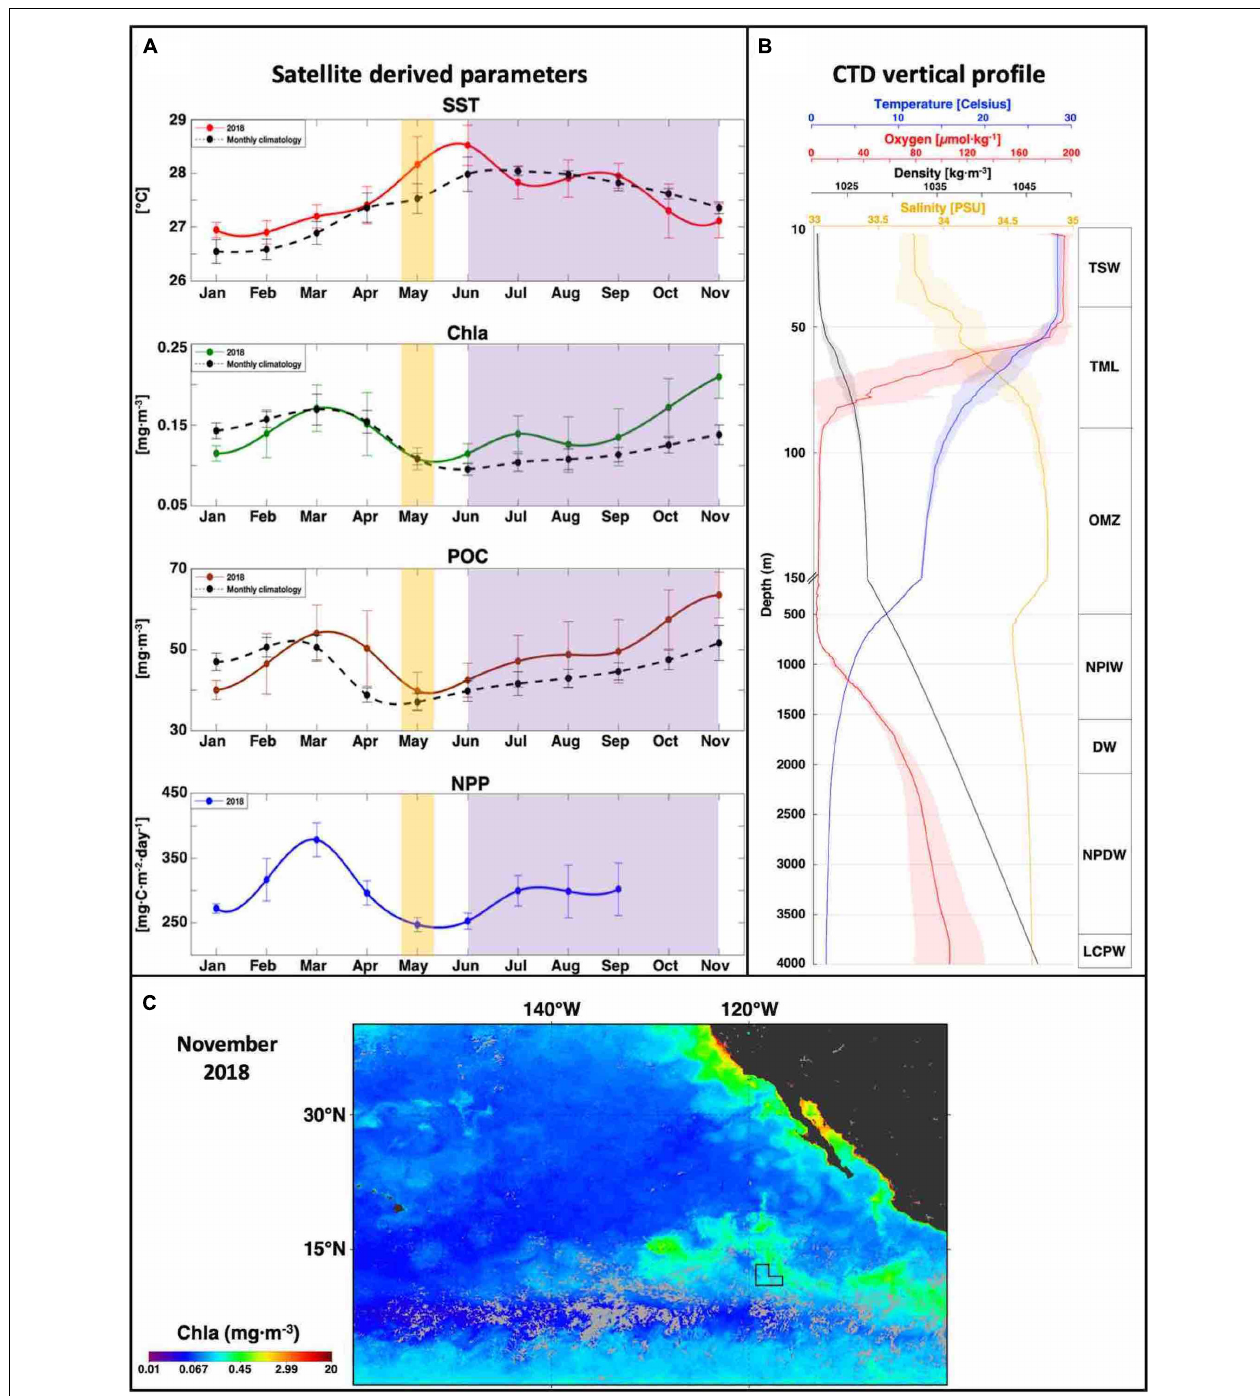
FIGURE 4 | Oceanographic condition of the eastern German license area in CCZ. (A) Surface water characteristics using satellite (MODIS) derived parameters including sea surface temperature (SST), Chlorophyll a (Chla), particulate organic carbon (POC) and net primary production (NPP). Yellow shaded areas represent the timeframe during which all profiles were acquired, and purple shaded areas indicate the hurricane season (Neumann, 1993). (B) Vertical water mass characteristics using CTD downcast profiles. Bold lines represent the median values and shaded areas indicate the variation from all profiles. The vertical water mass distribution is shown on the right-hand side: Tropical Surface Water (TSW), Thermocline Layer (TML), Oxygen Minimum Zone (OMZ), North Pacific Intermediate Water (NPIW), Deep Water (DW), North Pacific Deep Water (NPDW) and Lower Circumpolar Water (LCPW). (C) November 2018 surface Chla distribution in the north-eastern Pacific. Light gray corresponds to cloud coverage and the eastern German license area is indicated by an L-shaped black polygon.